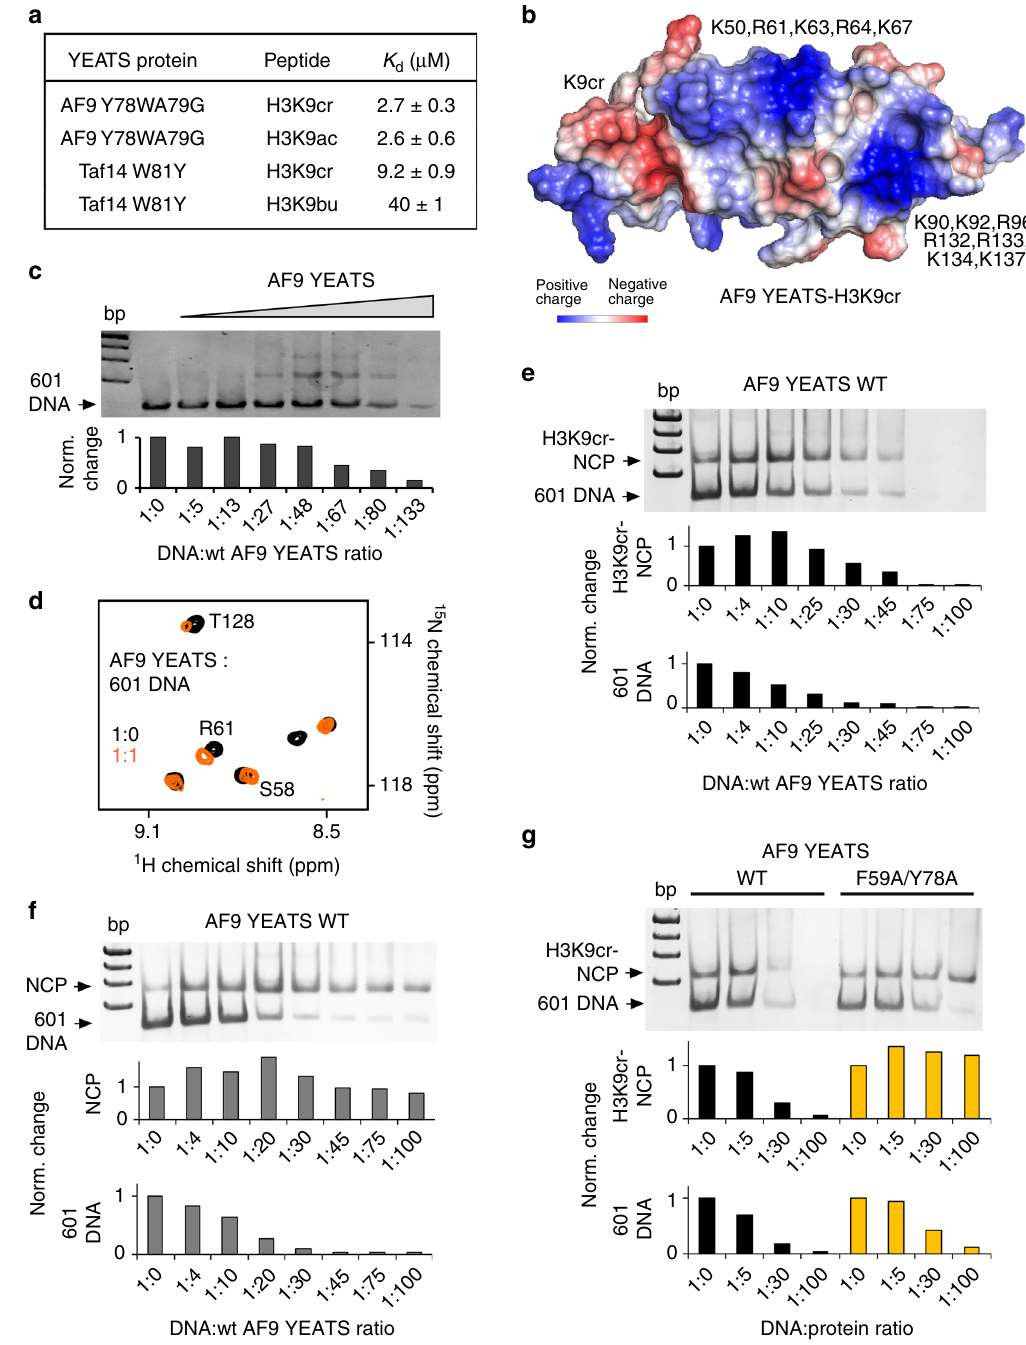
Fig. 5 AF9-YEATS binds DNA. a Binding af fi nities of AF9-YEATS and Taf14-YEATS to indicated histone peptides. Values represent the average of three separate experiments with error calculated as the SD between the runs. b Electrostatic potential surface representation of the AF9-YEATS in complex with H3K9cr generated in PyMol (PDB ID 5hjb). Basic residues are labeled. c EMSA with 147-bp 601 DNA (1.88 pmol/lane) incubated with increasing amounts of AF9-YEATS. DNA to protein molar ratio is shown below the gel image. d Superimposed 1 H, 15 N HSQC spectra of uniformly 15 N-labeled AF9-YEATS collected upon titration with 601 DNA. The spectra are color coded according to the protein:DNA molar ratio. e – g EMSA assays with 1 pmol/lane H3K9cr- NCP ( e , g ) or unmodi fi ed NCP ( f ) incubated with increasing amounts of WT AF9-YEATS or F59A/Y78A mutant. Band intensities in ( c , e – g ) were quanti fi ed by densitometry using of conservation of DNA-binding activities in YEATS readers discovery of the DNA-binding function for AF9-YEATS expands derived from different organisms. the family of epigenetic readers capable of bivalently interacting with histone tails and nucleosomal DNA. These include the Tudor domain of PHF1 25,26 , the PWWP domains of LEDGF and PSIP1 27,28 , the PZP domain of BRPF1 29 , and bromodomain of BRDT 30 . It will be interesting in future studies to explore the idea